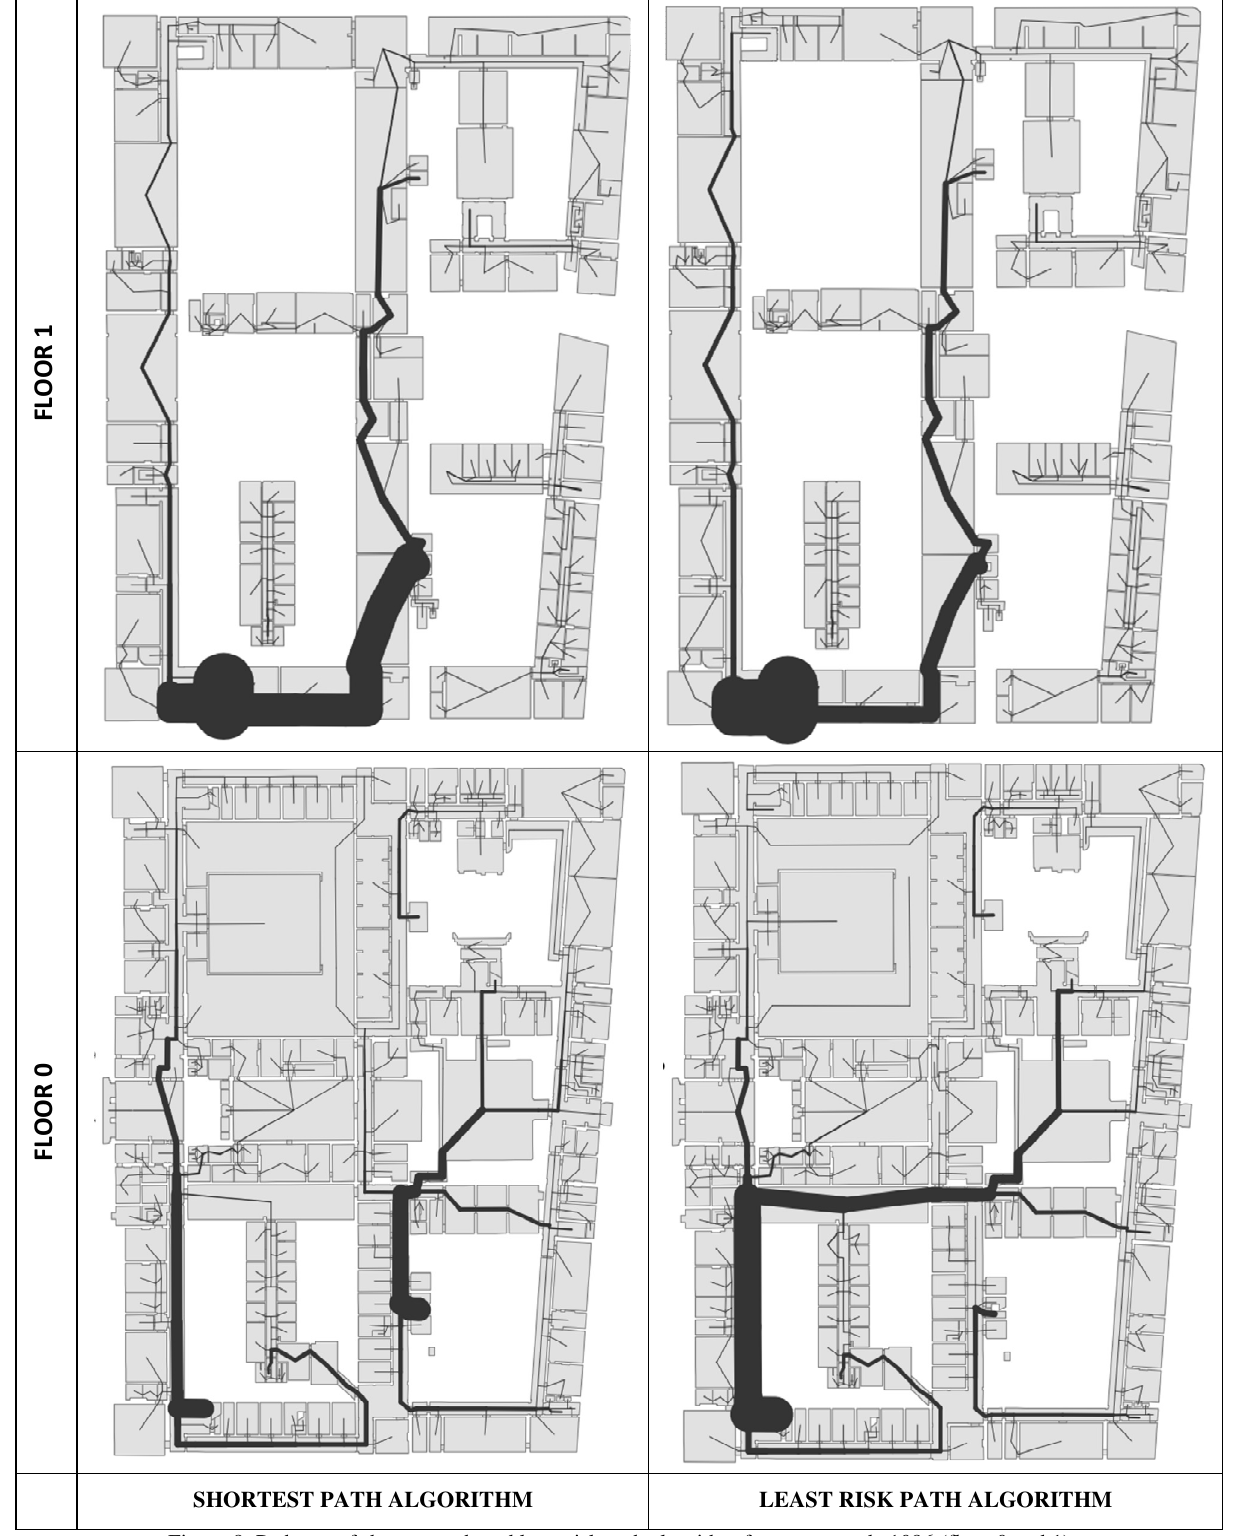
Figure 8: Path use of shortest path and least risk path algorithm for source node 1086 (floor 0 and